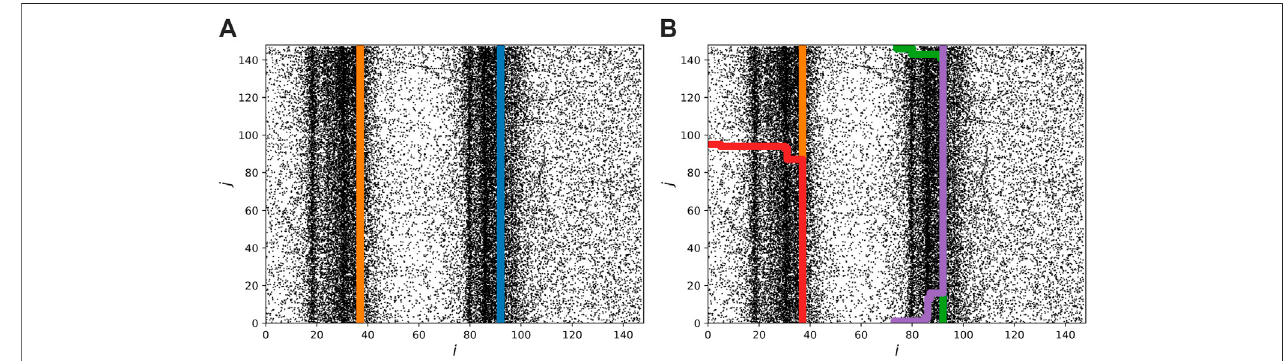
FIGURE 7 | Area A : (A) The two most optimal paths between the intervals along different edges. (B) The fi ve most optimal paths between different edges. Each edge has been divided into two intervals, and fi xing α (cid:3) 0 . 8, and β (cid:3) 0 . 8.